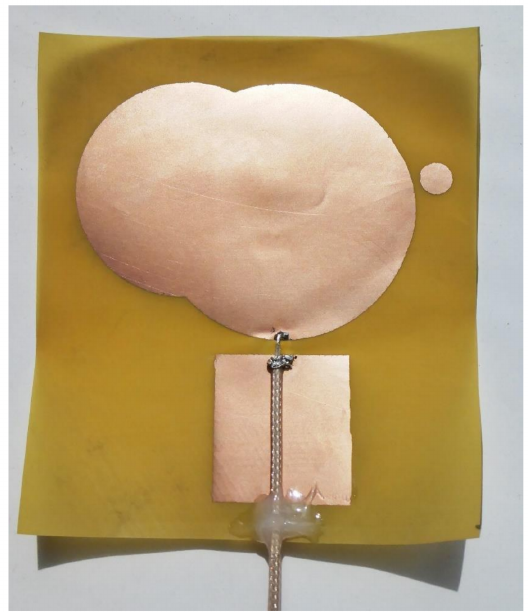
Figure 17. The prototype of three circle antenna fabricated with thin flexible